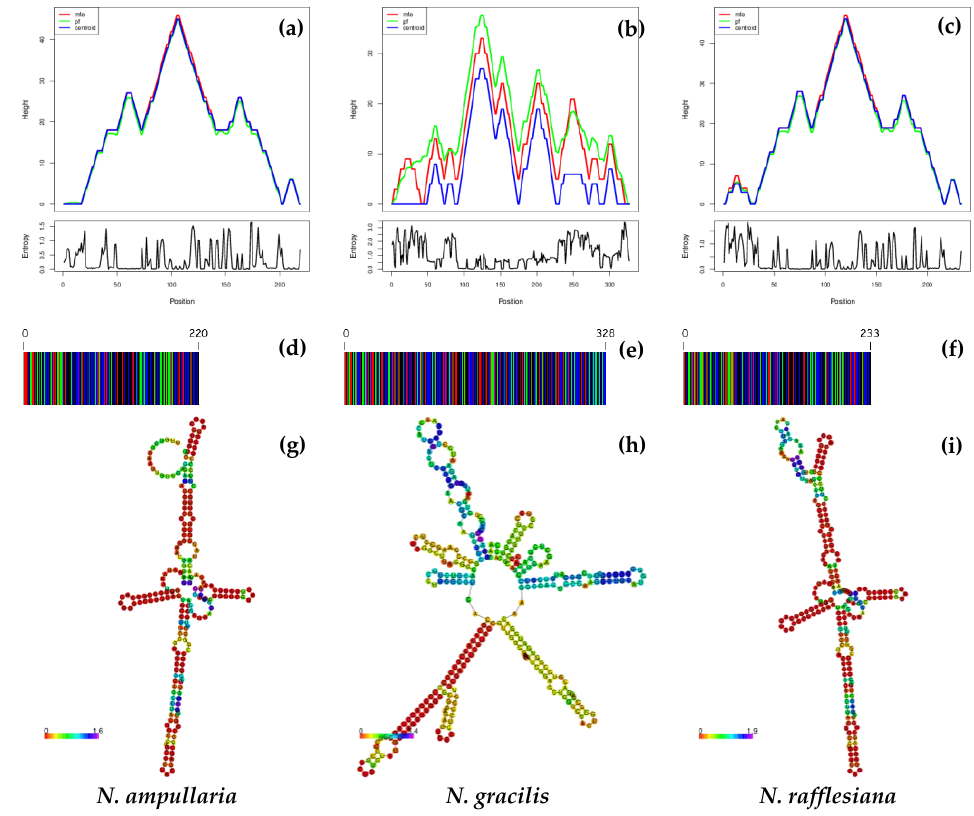
Figure 5. The variations observed in the predicted minimum free energy (MFE) ( a – c ), DNA barcodes ( d – f ), and secondary structures of the ITS1 region for the three Nepenthes species ( g-i ).